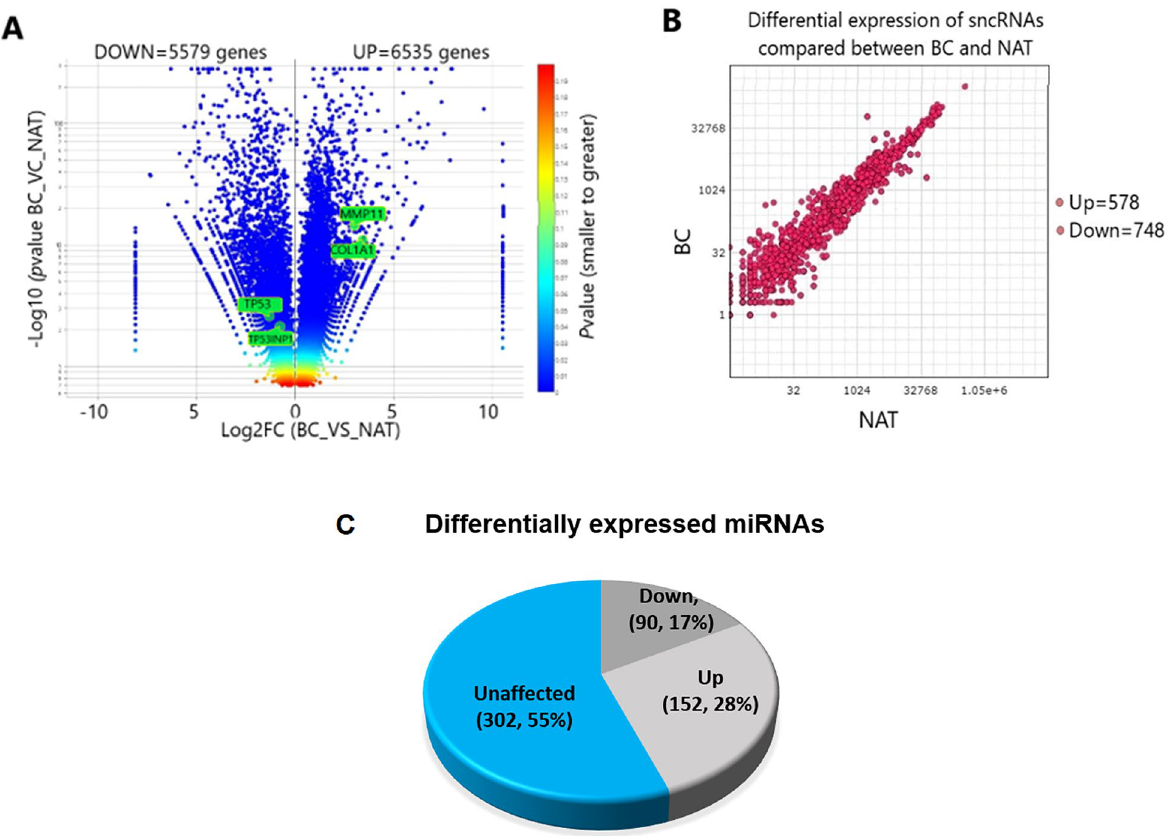
Figure 1. Analysis of the differential expression of mRNAs and small RNAs. ( A ) Volcano plot showed the comparison of the differential expression of 12,114 genes between BC and NAT. each plot denotes only one mRNA transcript. The selected target genes for miR-4510 were pointed and named. ( B ) Scatter plot displayed small RNA differential expression. Each red dot on the plot denoted only one small RNA. ( C ) The total number of miRNA differential expression was